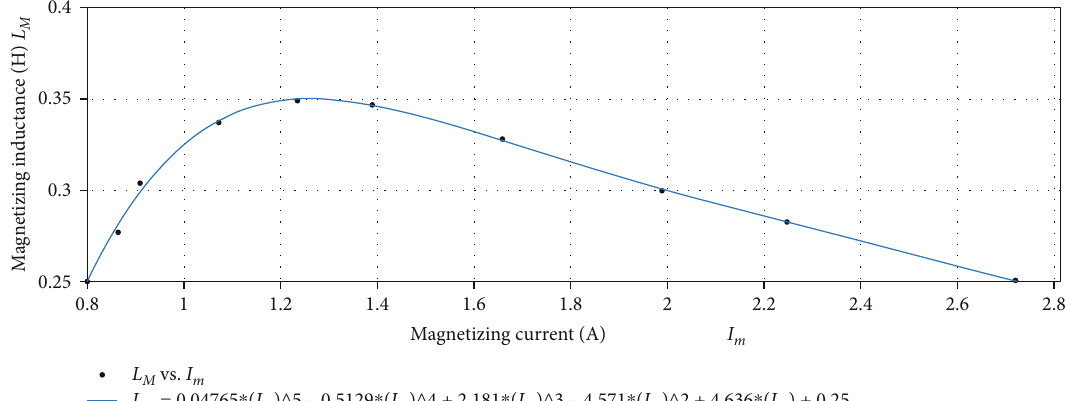
Figure 3: Variation of magnetizing inductance with the magnetizing current of the induction machine.